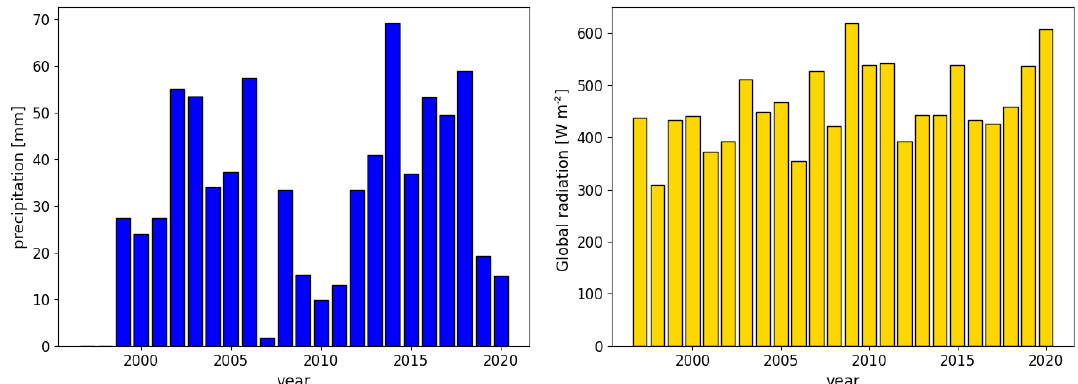
Figure A4. Time series of the monthly accumulated precipitation and mean solar irradiance between 10:00 and 14:00UTC at the Wettermast Hamburg for April from